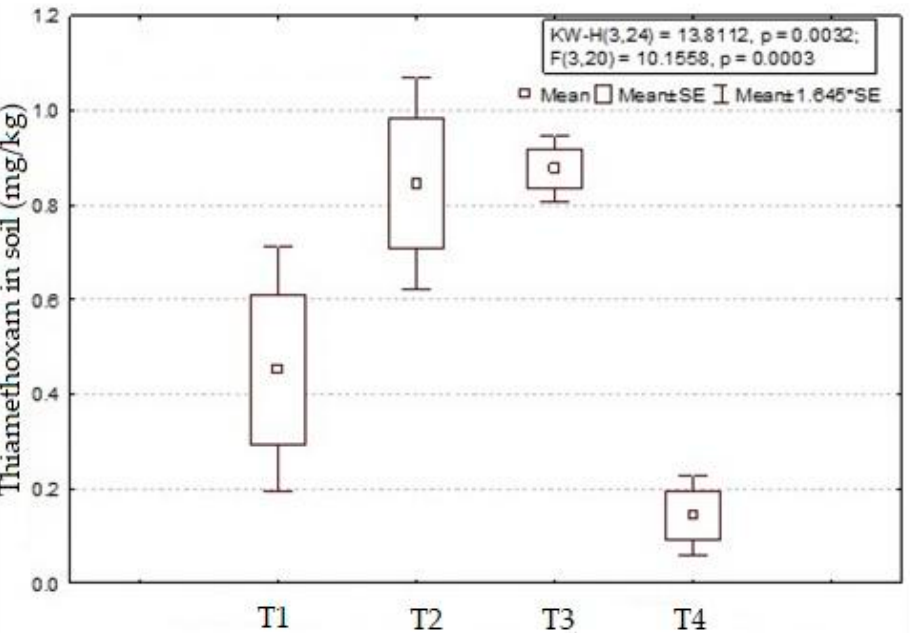
Figure 4. Concentration of thiamethoxam in soil (mg /Kg) in different stages of the papaya crop rotation with watermelon. Abbreviations: T1 = Watermelon cultivation; T2 = Soil preparation for papaya; T3 = Stage of papaya transplant; T4 = Papaya in production.